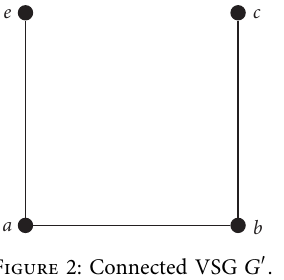
Figure 2: Connected VSG G ′